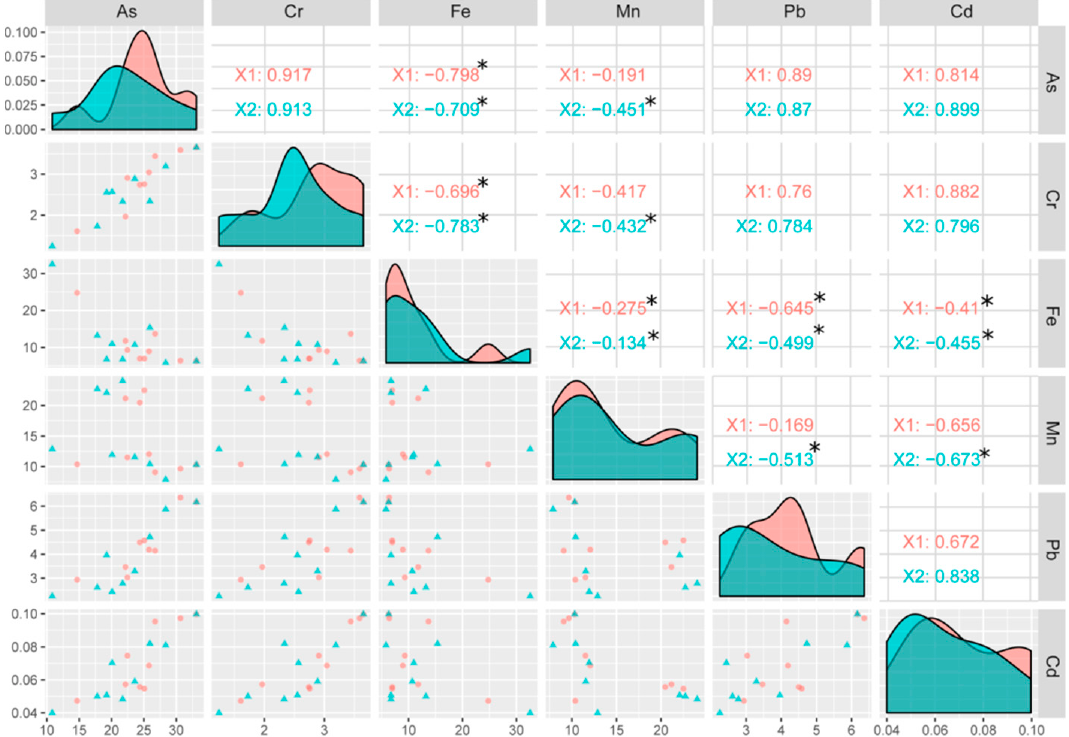
Figure 6. Correlation between the total content of different element concentrations in soil.